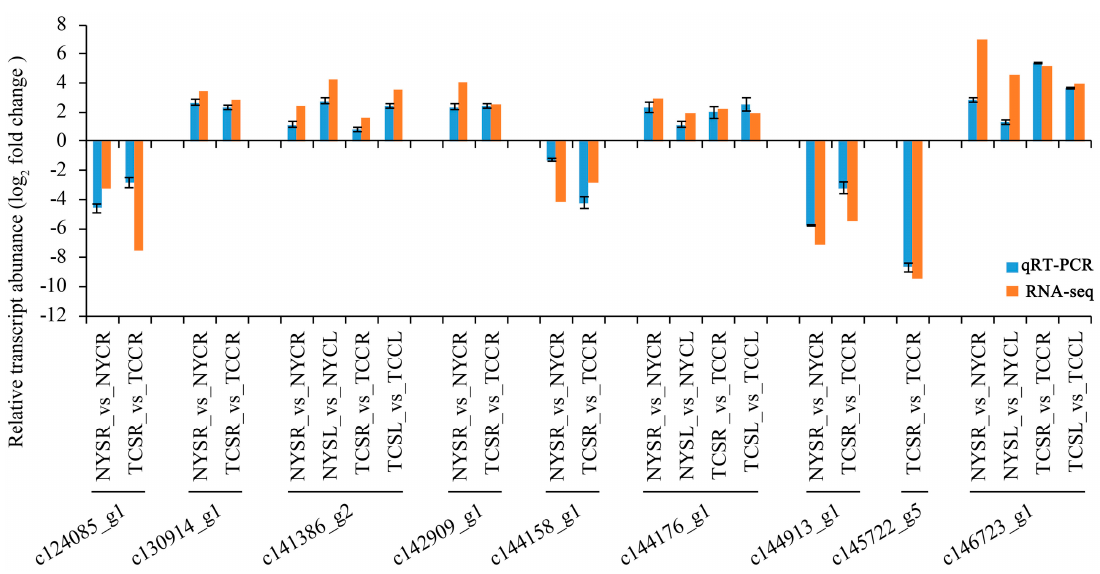
Figure 7. Quantitative real-time PCR (qRT-PCR) validation analysis of RNA sequencing of nine DEGs. Data represent log2(fold changes) to each DEG’s relative transcript abundance in NYSR (NY salt-stressed root) vs. NYCR (NY control root); NYSL (NY salt-stressed leaf) vs. NYCL (NY control leaf); TCSR (TC salt-stressed root) vs. TCCR (TC control root); TCSL (TC salt-stressed leaf) vs. TCCL (TC control leaf). The blue bars represent the expression via qRT-PCR and red bars represent expression via RNA-seq.